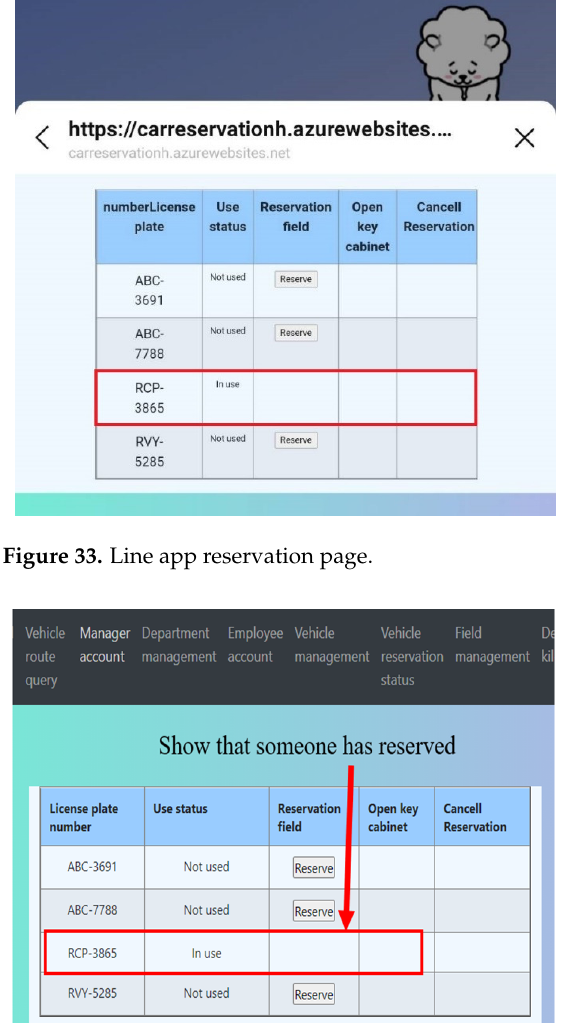
Figure 34. Vehicle reservation page.